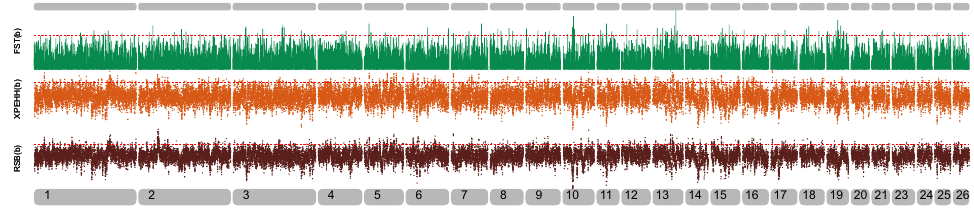
Figure 7. Manhattan chart of QR and DL vs. APD and ASU selective dissection analysis. The x-axis represents the chromosome, the green is the FST value standardized by the z-score, the orange is the xp-EHH value, and the black is the Rsb value.